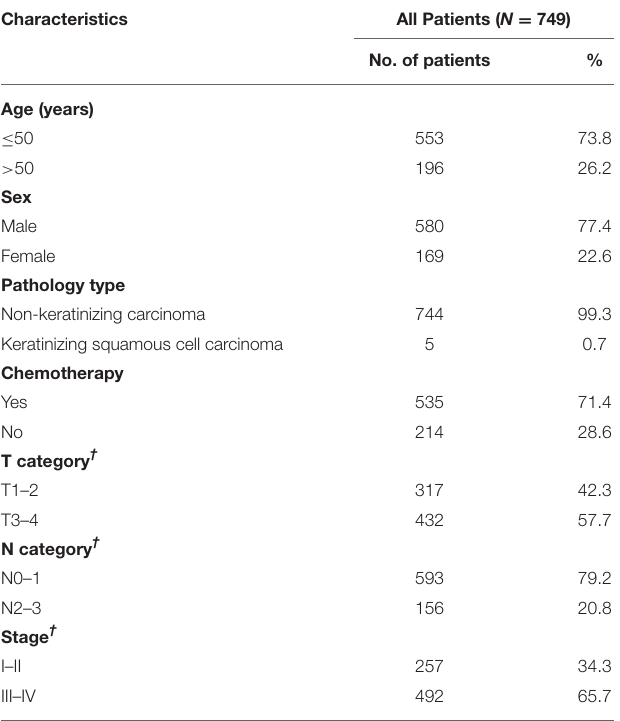
TABLE 2 | Patient baseline demographic and disease features.